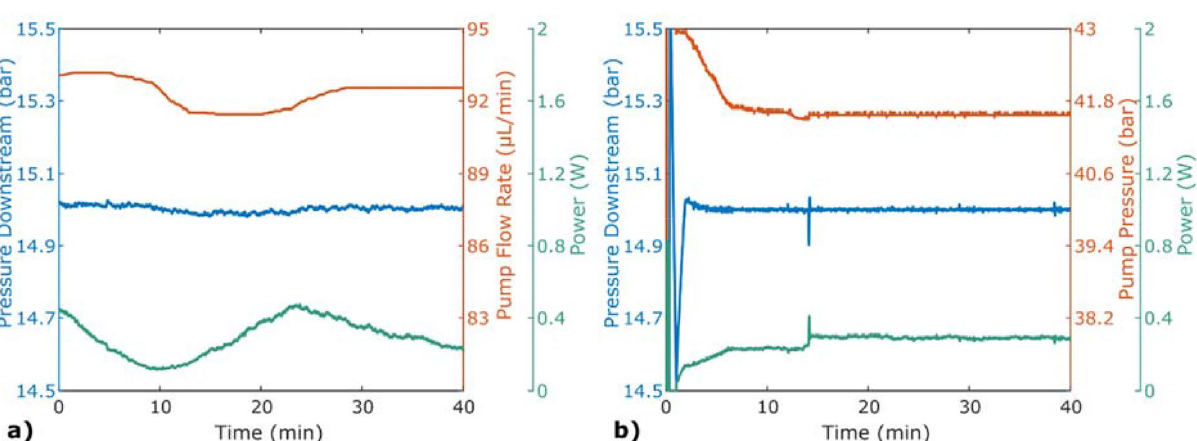
Figure 5. Stabilisation of pressure at 15 bar using an actively heated microfluidic chip, plotted against the control parameters. In the experiment, an ISCO pump was used with an external pressure sensor for feedback. The control parameters are the heater power and ( a ) pump flow rate, or ( b ) pump